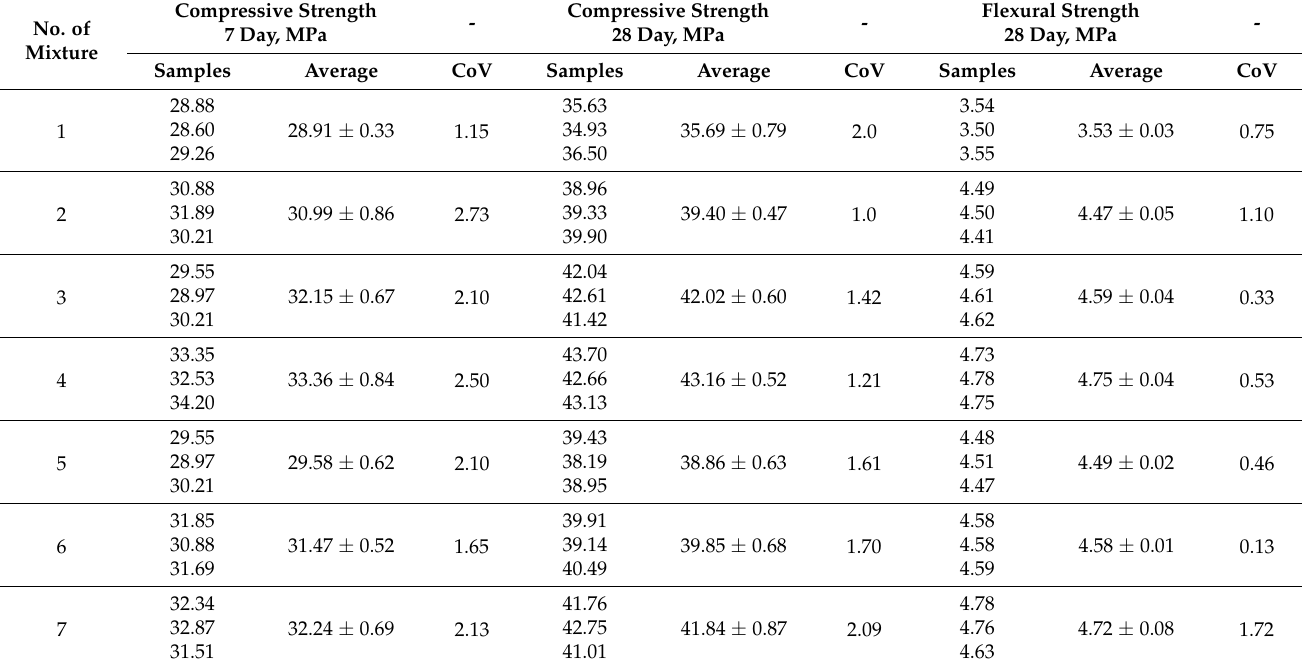
Table 2. Values of compressive and flexural strength (‘ ± ’ indicates standard deviation, ‘CoV’ indicates the coefficient of